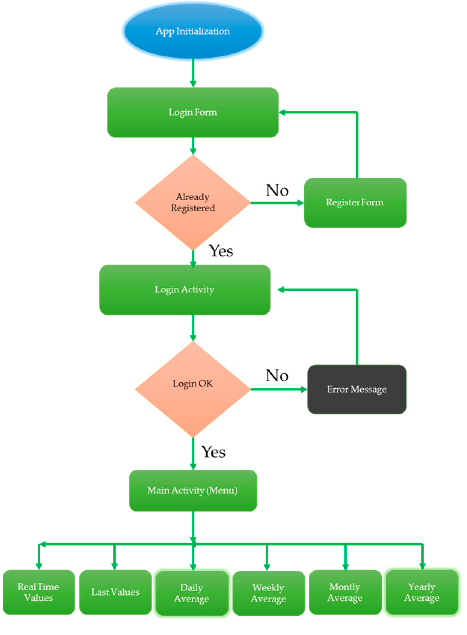
Figure 8. App flow-chart.